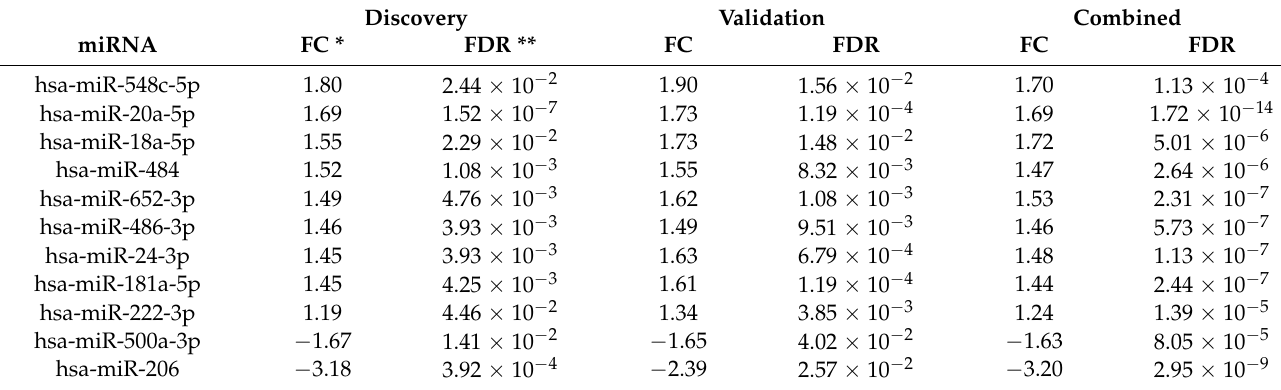
Table 2. Differentially regulated miRNAs in AIS versus TIA patients. Discovery Validation Combined